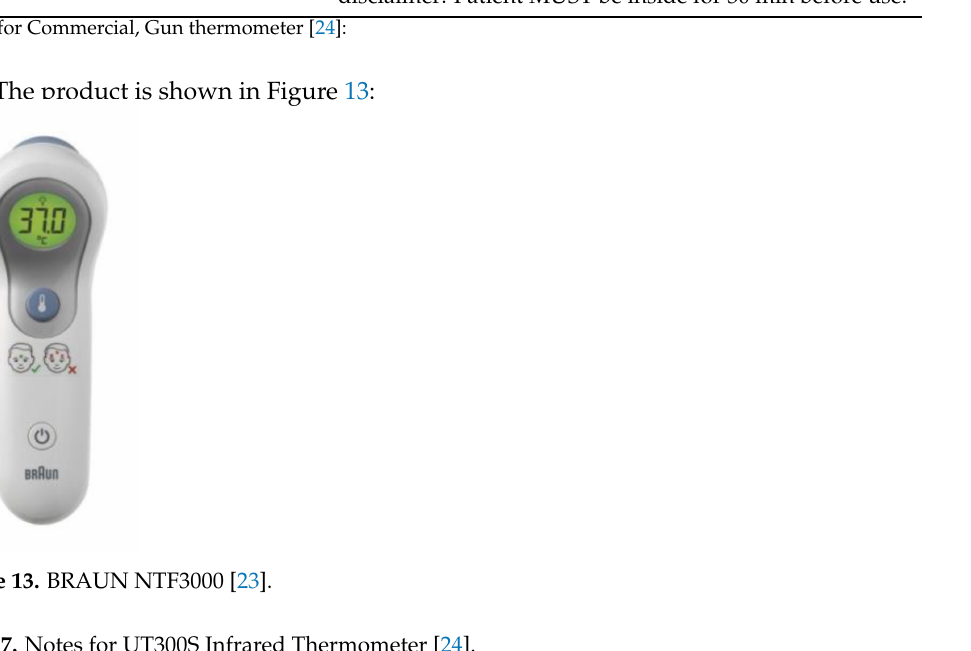
Table 7. Notes for UT300S Infrared Thermometer